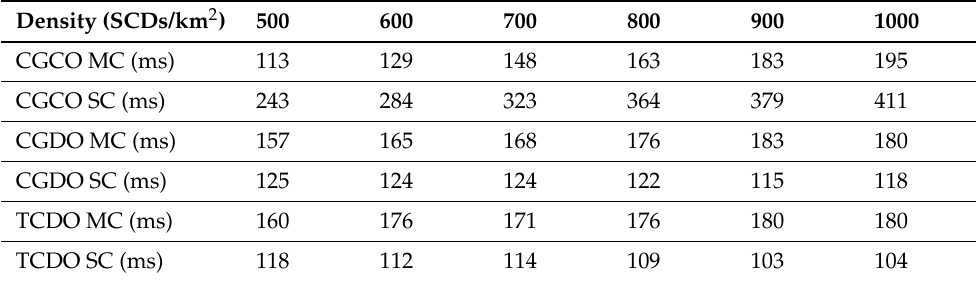
Table 6. The average execution time for solving one optimization problem of PA methods for different network